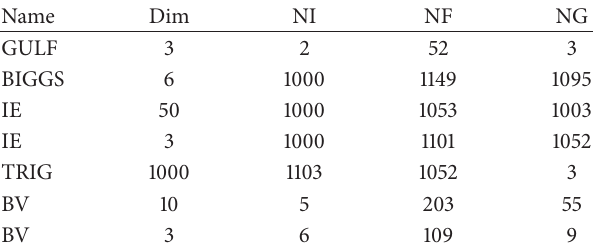
Table 2: Test results for Algorithm